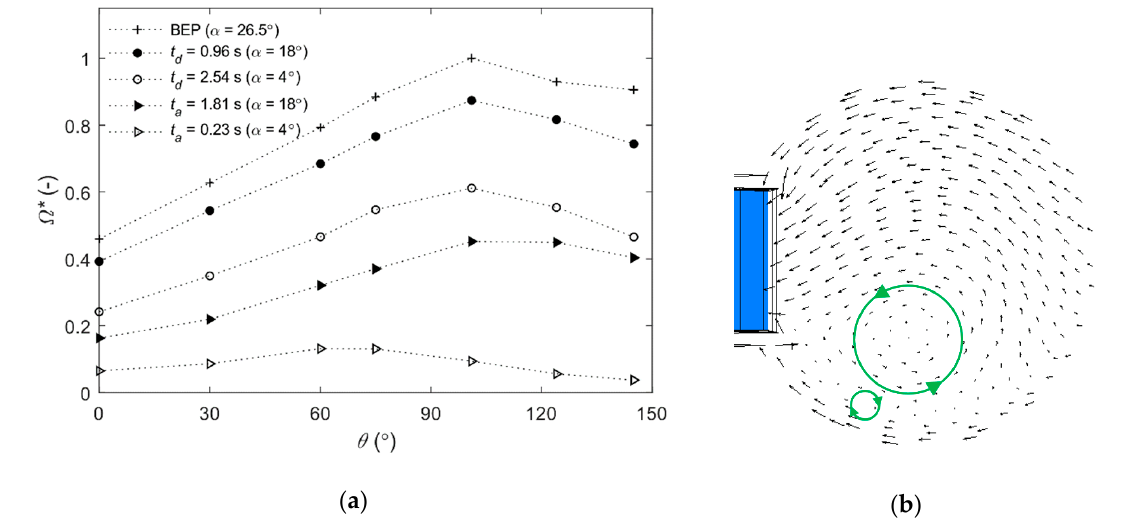
Figure 15. ( a ) Normalized total vorticity on the cross-sections along the SC at BEP and two time instants in acceleration and deceleration, corresponding to the same GVAs. ( b ) In-plane velocity vectors on θ = 101 ◦ plane at BEP showing secondary flow structure; vortices are schematically shown by the circles and direction by arrowheads.